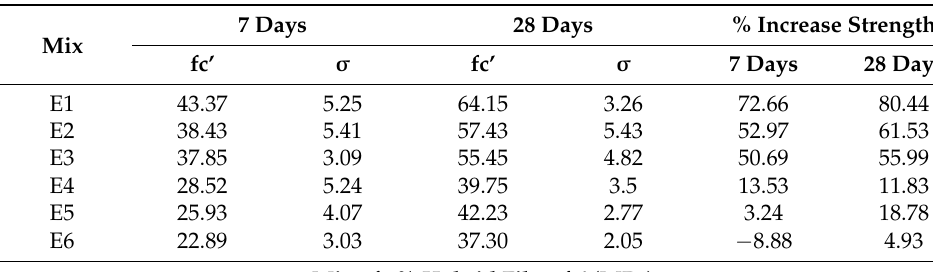
Table 5. A mix of unit weight ≤ 1825 kg/m 3 fc’(MPa) without